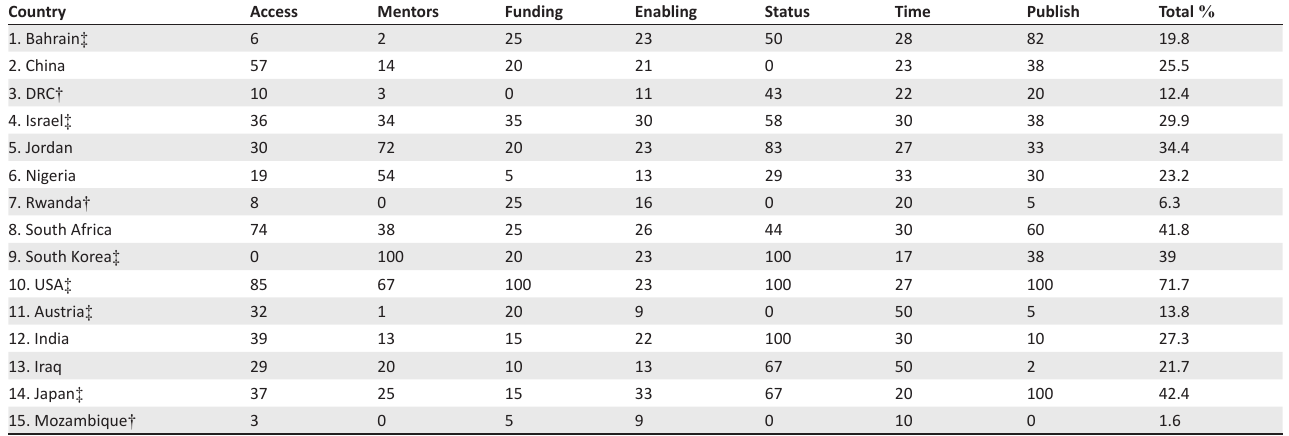
TABLE 3: Scores on all factors of 15 countries.